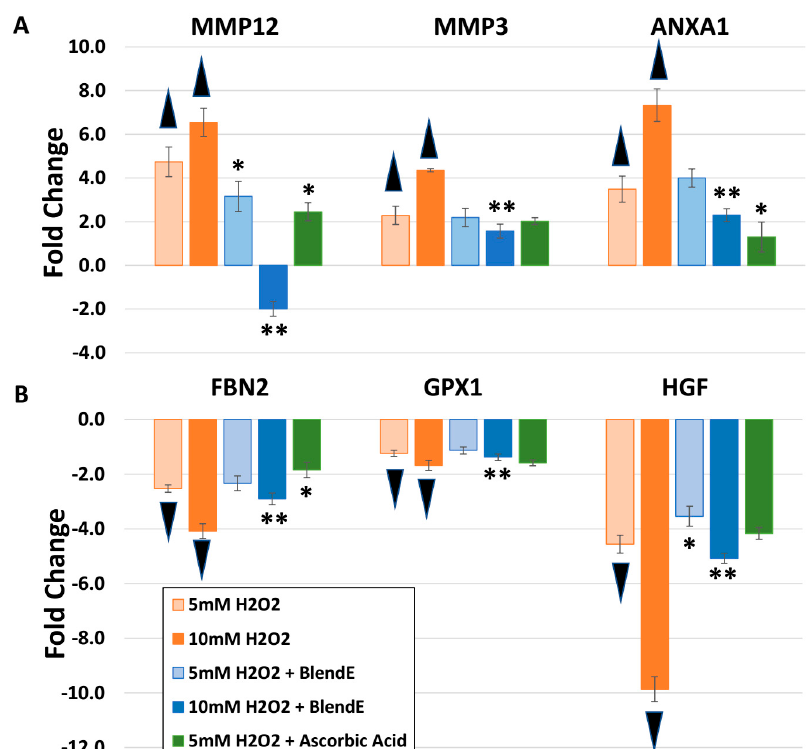
Figure 2. Effects of oxidative stress response on gene expression. Skin equivalents were challenged with 5 mM or 10 mM H 2 O 2 for 24 h. In addition, known antioxidant compounds, BlendE or ascorbic acids were added to the skin equivalent cultures containing H 2 O 2 to counteract the effects of hydrogen peroxide. Validated Taqman gene expression assays with relevance to the skin structure and function were examined using OpenArray. Unpaired t -tests were performed using StatMiner. Statistically-significant gene expression changes over the untreated are shown ( p ≤ 0.05). Standard deviation is shown as error bars. Five millimolar H 2 O 2 is shown in beige, and 10 mM H 2 O 2 is shown in orange. Five millimolar H 2 O 2 with BlendE is shown in light blue, and 10 mM H 2 O 2 with BlendE is shown in blue. Lastly, 5 mM H 2 O 2 with 50 mg/mL ascorbic acid is shown in green, where ascorbic acid served as the positive control. ( A ) Skin-specific targets with upregulation by H 2 O 2 are shown. ( B ) Skin-specific targets with down-regulation by H 2 O 2 are shown. Without H 2 O 2 challenge, BlendE alone did not modulate MMP12, MMP3, ANXA1, FBN2 and HGF, while GPX1 was stimulated as shown in Figure 1. ▲ indicates statistically-significant increase compared to control levels. ▼ indicates statistically-significant decrease compared to control levels. * indicates statistically-significant difference to 5 mM H 2 O 2 , and ** indicates statistically-significant differences to 10 mM H 2 O 2 (based on ANOVA, followed by pairwise comparisons, where appropriate).